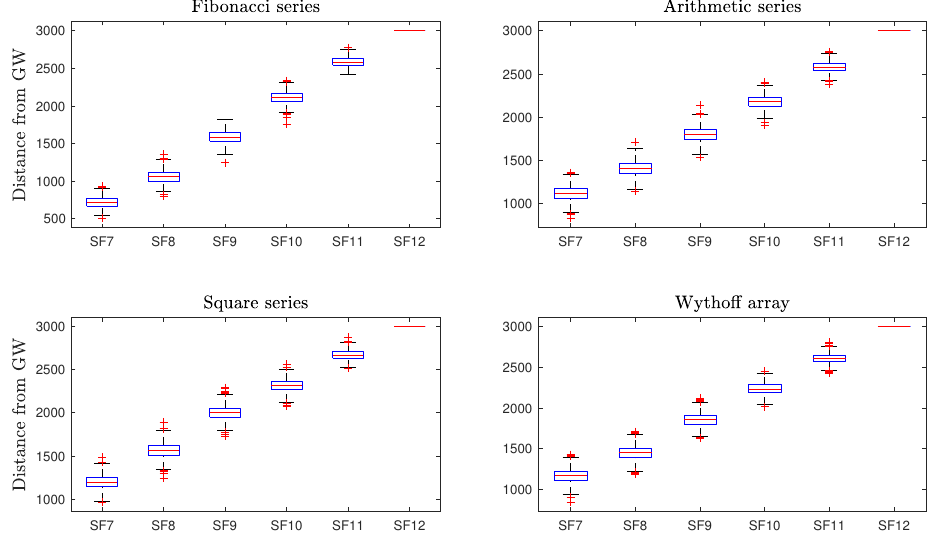
Figure 5. Boxplots representing the distance of SFs from the gateway. The red “+” signs indicate outliers. SF12 has a constant distance of 3 km for all of the